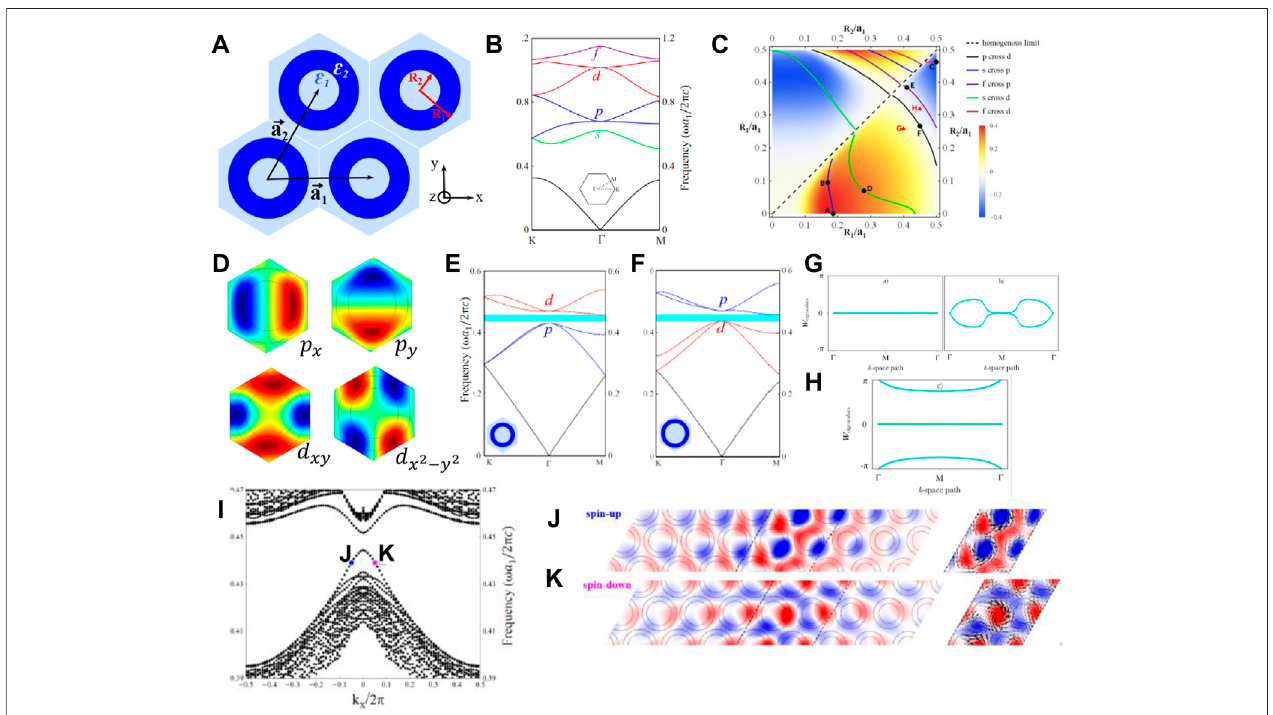
FIGURE 4 | Photonic analog of quantum spin Hall insulator [97, 101]. (A) Schematic con fi guration of a triangular PhC using core – shell dielectric. (B) Typical band structureofthecore – shellPhCs,where thephotonic-likeorbitsarelabeled. (C) Phasediagramofthe p − d inversion induced photonictopological insulator inthegeometric parameter spaces. (D) Eigen modes of p doublets ( p x , p y ) and d doublets ( d xy , dx 2 − y 2 ), which served as the photonic pseudospin DoF. (E, F) Band structure of core – shell PhCswith (E) trivialand (F) nontrivialband gaps.(G,H)Wanniercenterpositionsofthebandsbelowthe (G) trivialand (H) nontrivialbandgap.Reproducedpermission from Ref. 101. (I) Projected band structure of two PhCs with helical edge states. (J) and (K) are the E z fi eld pattern in (I). Reproduced permission from Ref.